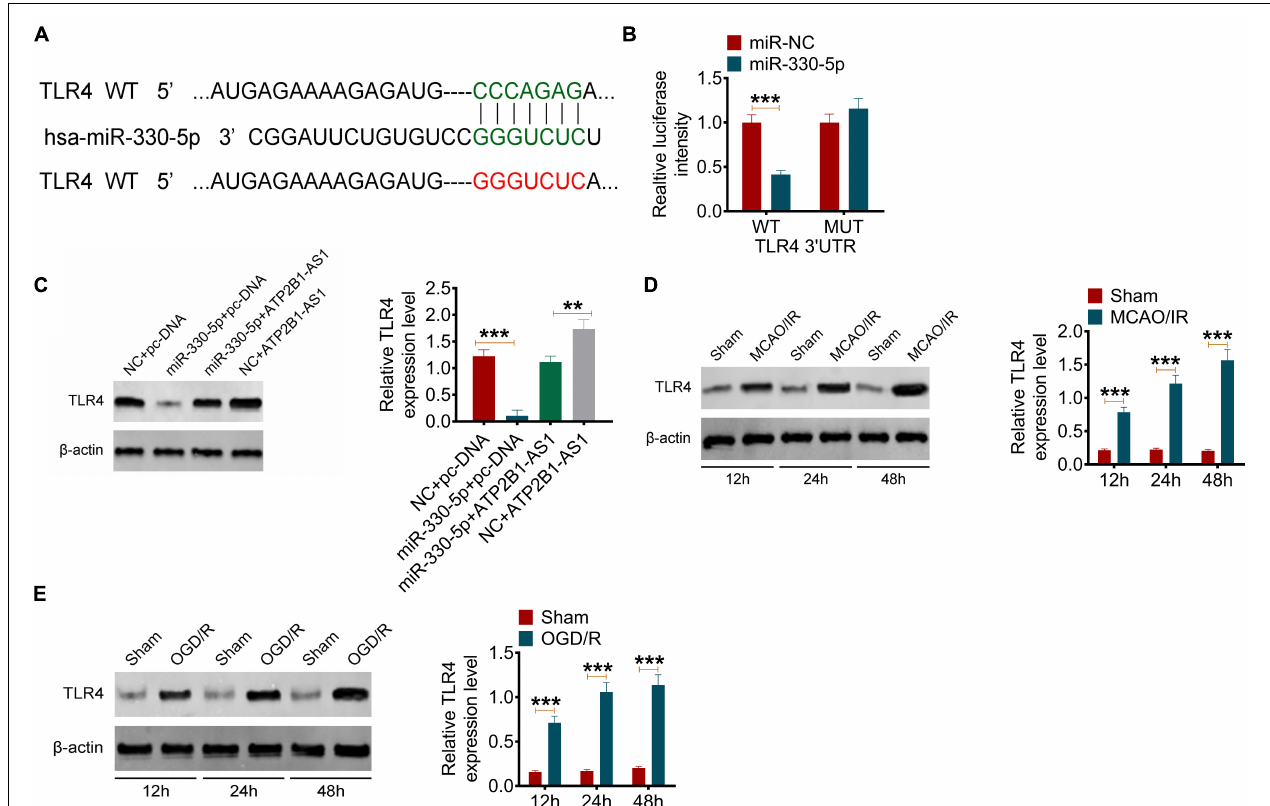
FIGURE 5 | MiR-330-5p targets TLR4 and the expression of TLR4 in MCAO/IR rats and OGD/R PC12 cells. (A) The target of miR-330-5p was predicted by TargetScan. MiR-330-5p could bind TLR4 3 (cid:48) UTR. (B) The binding of miR-330-5p and TLR4 was validated by a dual-luciferase reporter analysis. (C) The effect of ATP2B1-AS1 and miR-330-5p on the expression of TLR. (D) The protein expression of TLR4 in MCAO/IR rats for reperfusion for 12, 24, and 48 h was determined by Western blot. (E) The protein expression of TLR4 in OGD/R PC12 cells for reoxygenation for 12, 24, and 48 h was determined by Western blot. ** P < 0.01, *** P <